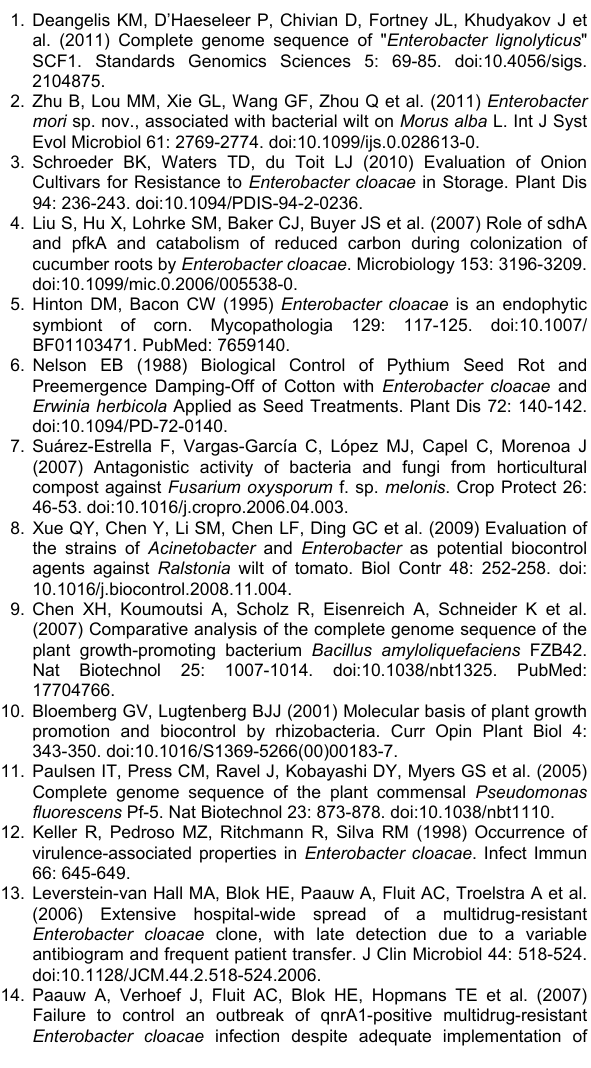
Figure S1. The comparative analysis of the CFA/I Fimbrial cluster. Table S1. Pan-genome analysis of Enterobacter by EDGAR.In brief, E. cloacae subsp. cloacae ENHKU01 was selected as reference genome and its gene contents were taken as the base set for stepwise comparison of the seven Enterobacter genomes involved in this study. For each round of all-against- all comparison based on a bidirectional best BLAST hit, every gene in a Enterobacter genome that has no ortholog in the base set was added to the reference set and compared with the next genome. The process was repeated step by step to obtain the pan-genome of Enterobacter [27].